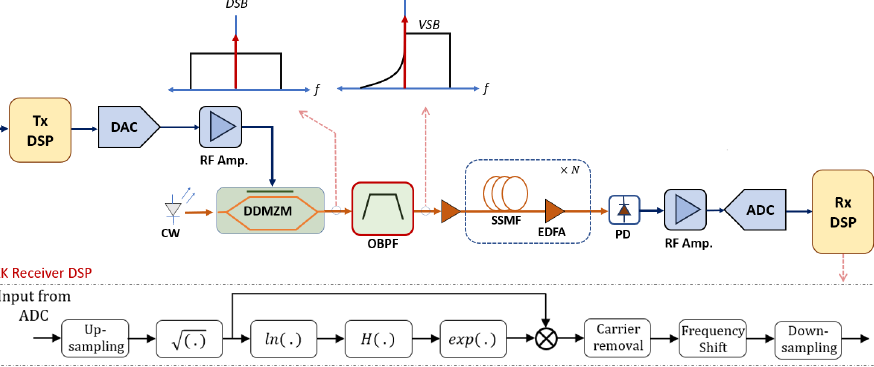
Figure 6. KK algorithm implemented in DSP for full optical field reconstruction. Table 1. Recent demonstrations that have broken records in terms of data-rate and transmission distance with SSB modulation and KK